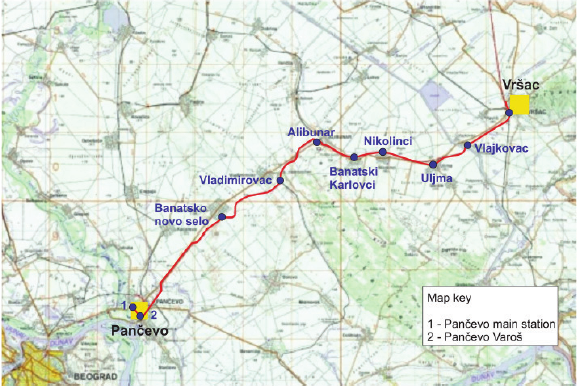
Figure 2. Railway line of Pančevo-Vršac